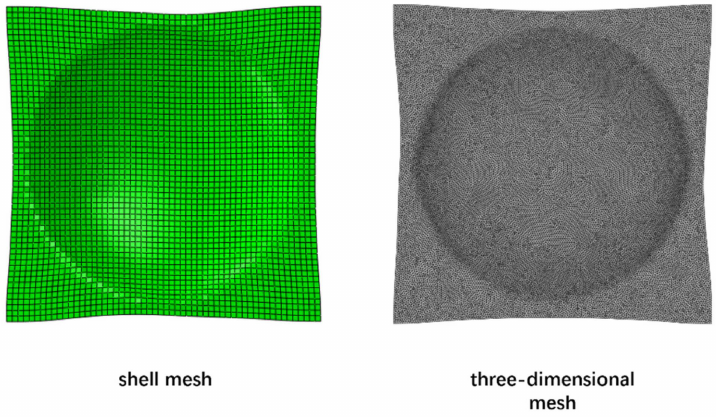
Figure 14. Dual mesh deformation.